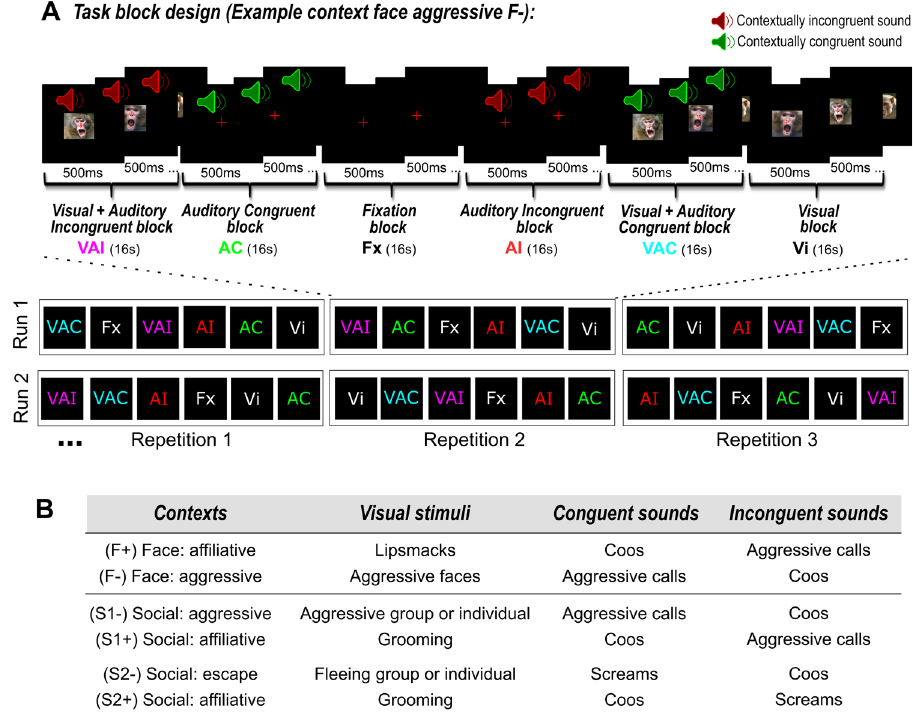
Fig. 1 | Description of experimental design and the six different contexts used in the study. A Experimental design. Example of an aggressive face (F − ) context. Each run was composed of three randomized repetitions of six different blocks of 16s. The six blocks could be either visual stimuli only (Vi), auditory congruent stimuli only (AC), auditory incongruent stimuli only (AI), audio-visual congruent stimuli(VAC) or audio-visualincongruent stimuli (VAI),or fi xation with no sensory stimulation (Fx). Block presentation was pseudo-randomized and counter- balancedsothat,acrossallrepetitionsandallrunsofgivencontext,eachblockwas, on average, preceded by the same number of blocks from the other conditions. Initialblockswereeitheravisualblock(Vi,VAC,VAI),ora fi